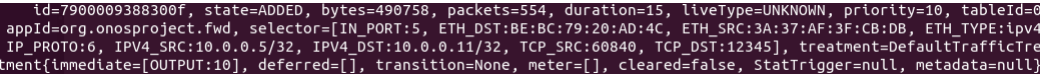
Figure 12. Installed flow rule for normal packets.